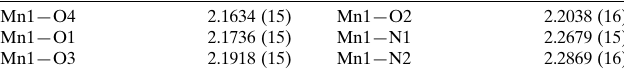
Selected bond lengths (A˚ ).